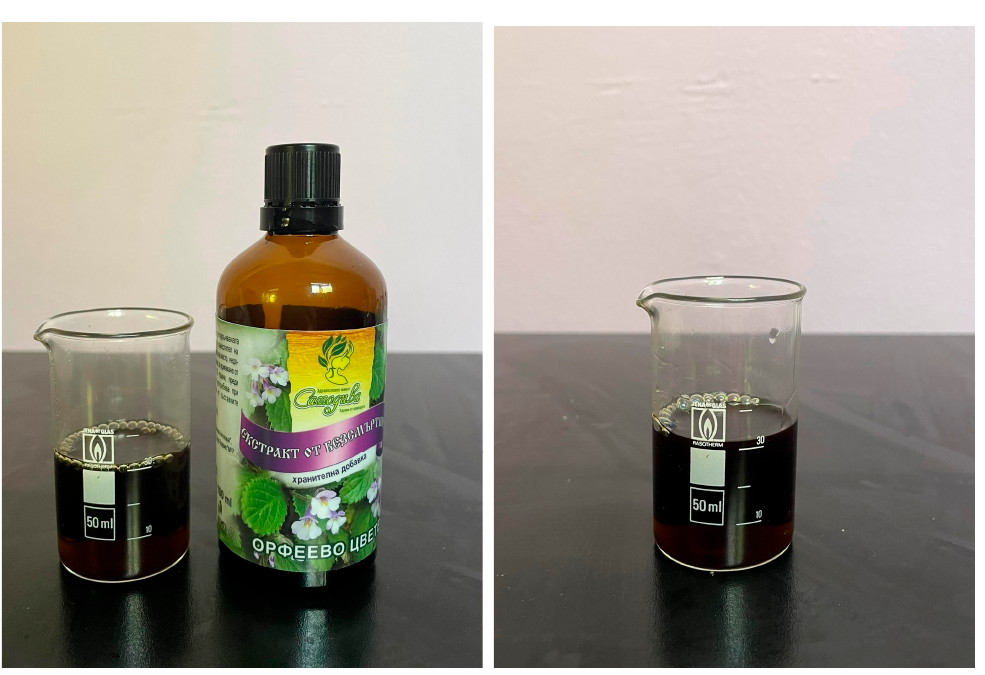
Figure 2. Haberlea rhodopensis blossom extract. Figure 3 illustrates flowers of H. rhodopensis . Table 2. Chemical composition of H. rhodopensis